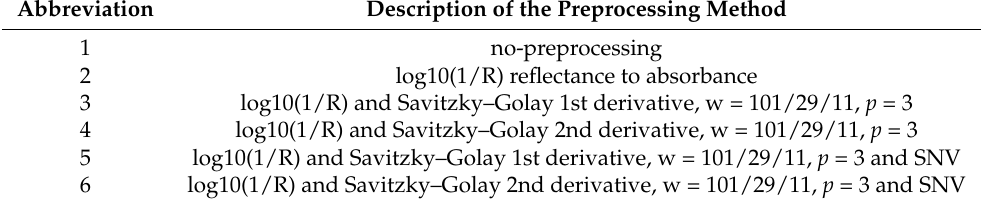
Table 2. Preprocessing methods applied to the spectral data (w = window size, p = polynomial order, the different window size numbers represent the different sensors (PSR+ 3500, HySpex and PRISMA